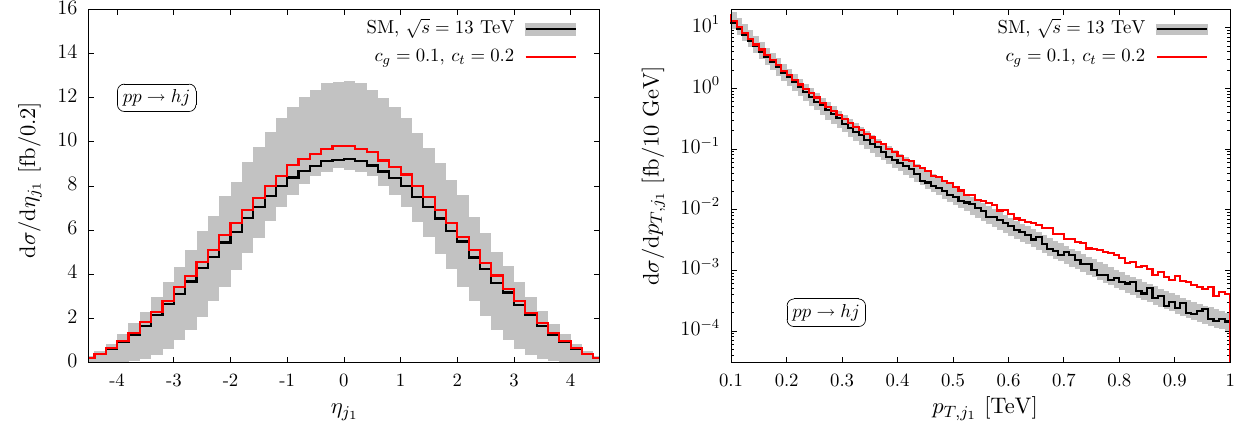
Fig. 1 Predictions for Higgs+jet production for approximate cancel- lations of Wilson coefficient choices that can be resolved for large momenta. The uncertainty (grey band) is evaluated by factorisation